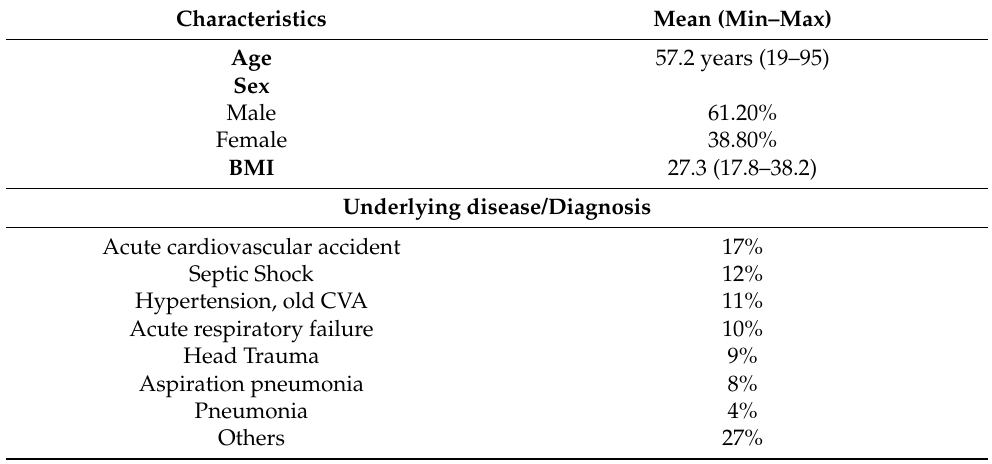
Table 1. Patients